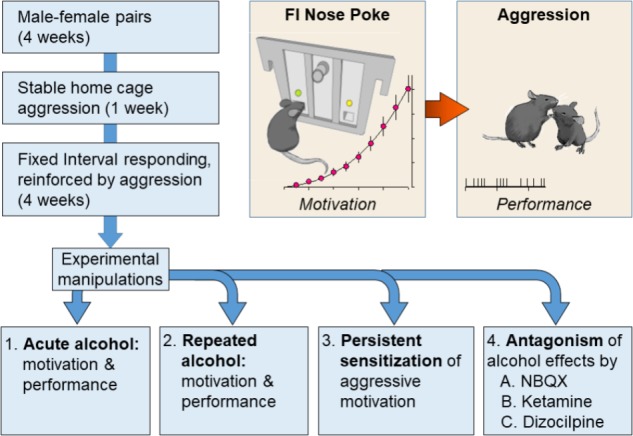
Resident male C57BL/6J (C57) mice were housed with breeding C57 females for at least 1 month. In daily resident–intruder confrontations, each resident male encountered a novel, male C57 intruder for 5 min in the resident home cage. After establishing an aggressive phenotype, each resident was trained during a fixed interval (FI) schedule that was reinforced by the presentation of an intruder. The FI was progressively increased from 1 s to 10 min over the course of 1 month. Mice were divided into experimental groups upon establishing consistent patterns of FI responding. Experiment 1 revealed the effects of acutely administered water or EtOH (0.5, 1.0, or 1.8 g/kg, PO) on FI responding and subsequent aggressive behavior. Experiment 2 evaluated the effects of repeated daily administrations of EtOH (1.8 or 2.2 g/kg, PO) on FI and aggression trials. Experiment 3 confirmed and extended these findings by measuring the persistence of alcohol-escalated motivation to fight. Experiment 4 examined the role of iGluRs during the expression of sensitized FI responding and aggressive performance in response to a 1.0 g/kg EtOH challenge that occurred at least 10 days after repeated administrations of water or EtOH (2.2 g/kg, PO).